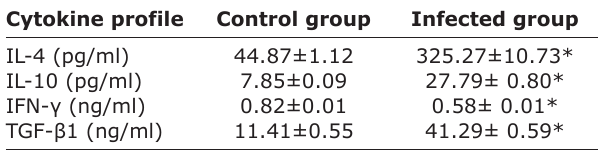
Table-2: Cytokine profiles (Mean±S.E), for normal (Control group) and Fasciola hepatica infected cattle (Infected group).